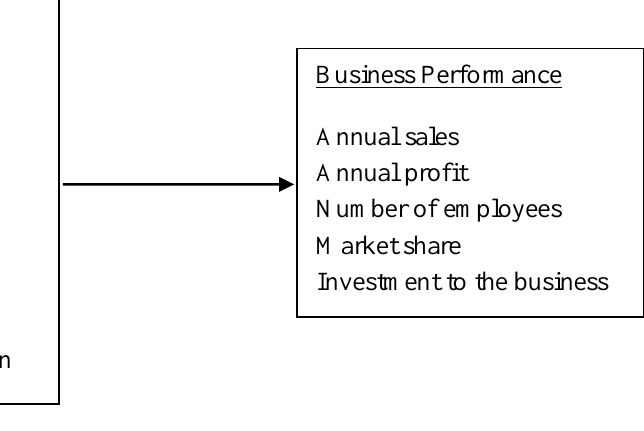
Figure 2.1: Conceptual